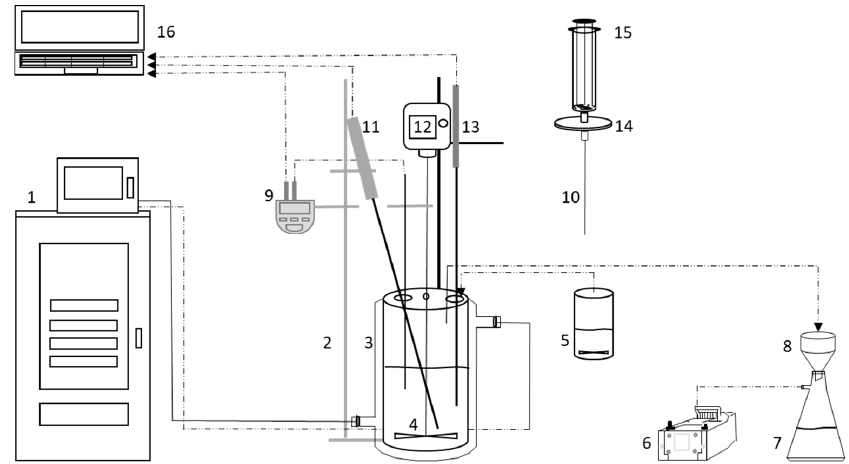
Figure 1. Scheme of the experimental setup. 1 Temperature control system; 2 Universal stand; 3 250ml-Jacketed glass crystallizer; 4 Glass impeller; 5 Reservoir for saturated solution of KCl; 6 Vacuum pump; 7 Buchner flask; 8 Buchner funnel; 9 Pt-100 sensor; 10 Syringe needle; 11 FBRM probe; 12 Overhead stirrer; 13 ATR-FTIR probe; 14 Disposable syringe filter; 15 Syringe; 16 Data acquisition system.